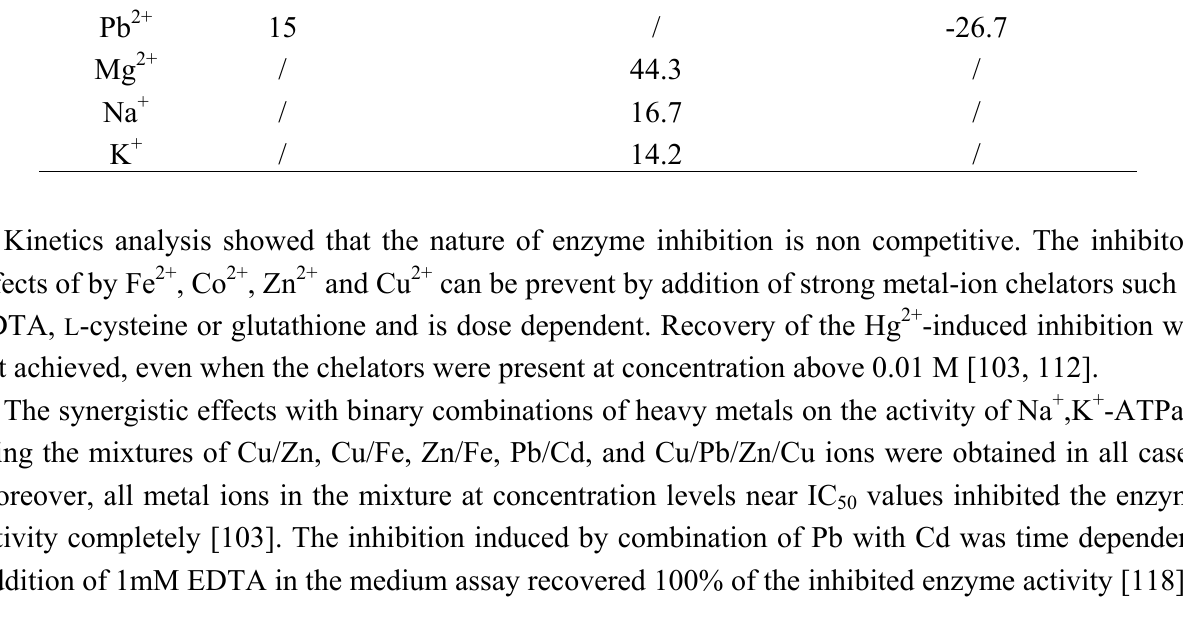
Table 2. IC values ( μ M) for Na + ,K + -ATPase inhibition by some metal ions and free 50 activation energy ( ∆ G o' ) (kJ mol -1 ) for water exchange and solubility constants (K